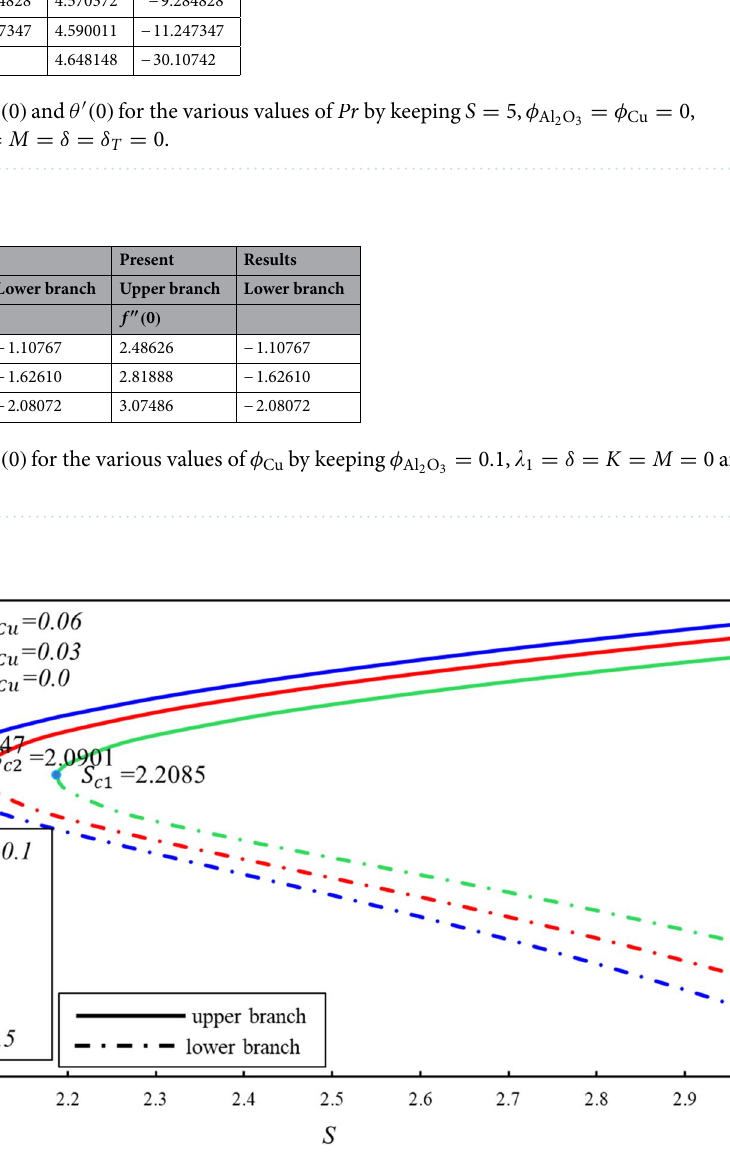
Figure 2. Behavior of f ′′ ( 0 ) in impact of φ Cu